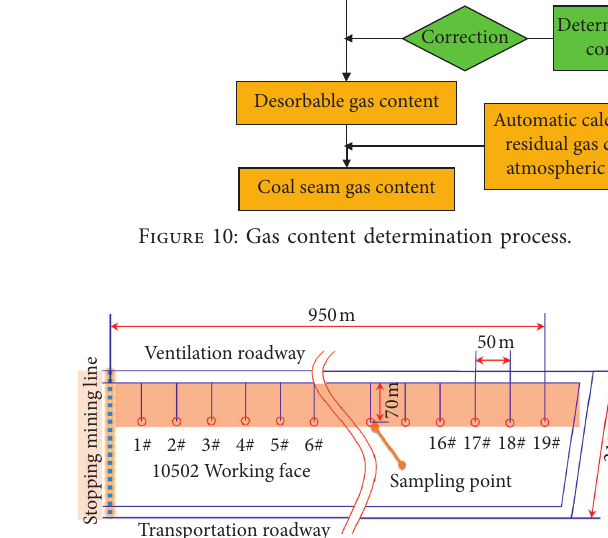
Figure 11: Sketch map of gas content measurement drilling in the ventilation